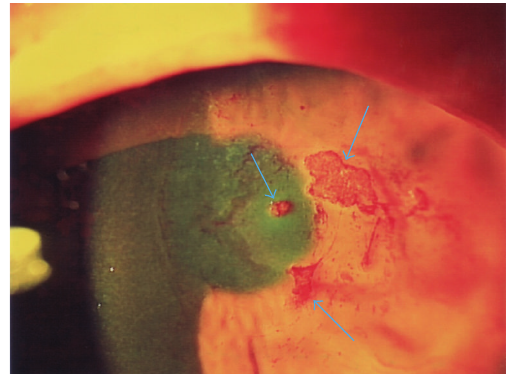
Figure 2: Atypically larger mucin balls found at post-operative day 11 wearing silicone hydrogel lens. They were stained with rose bengal dye (arrows).